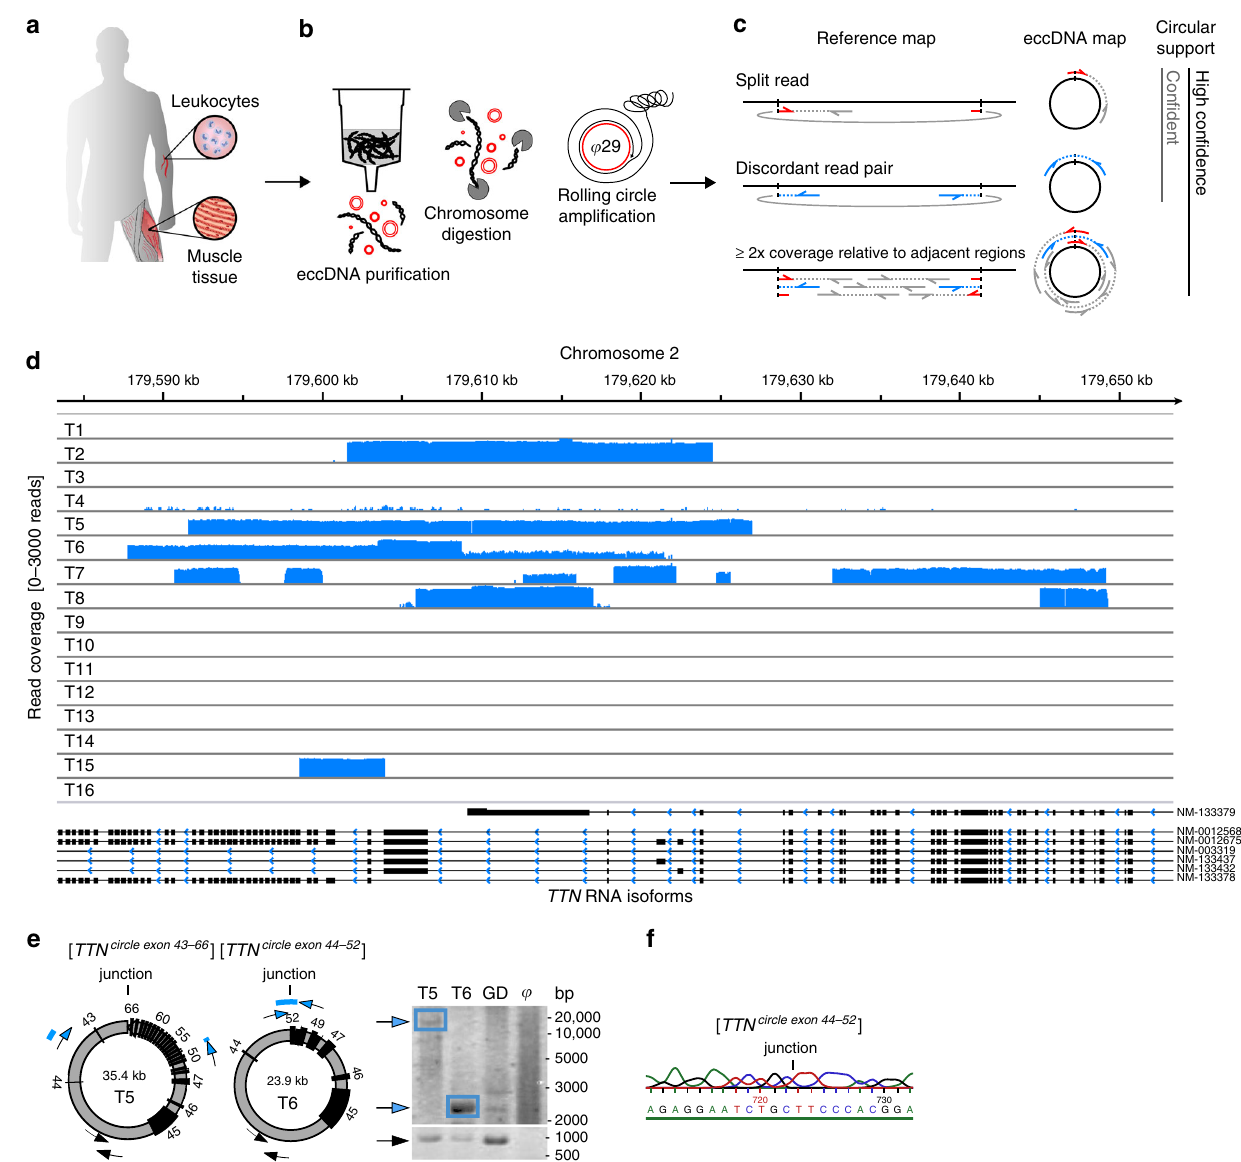
Fig. 1 Circle-Seq method for mapping of eccDNA. a Leukocyte and muscle samples from 16 healthy subjects (T1 – T16, n = 16). b Puri fi cation of eccDNA through column separation, exonuclease treatment, and rolling-circle ampli fi cation. c Detection of eccDNA based on structural-read variants and coverage (soft-clipped, split, red; concordant, gray; and discordant reads, blue). d Read coverage display (log-scale) at the titin gene, TTN , from muscle samples. e EccDNA from T5 and T6 illustrated (black boxes, exons), outward PCR validation (blue arrows), inward PCR (black arrows), and gel-image of T5 and T6 PCR products next to controls: GD, human genomic DNA; φ , phi29-ampli fi ed eccDNA sample without detected [ TTN circle ]. f Sequence of [ TTN circle exon 44-